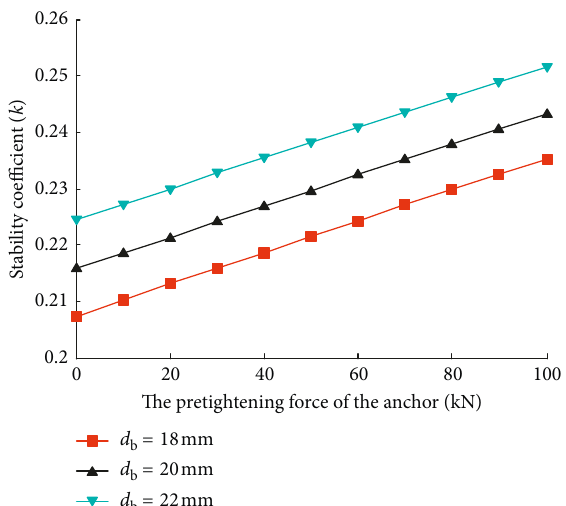
Figure 9: Influence of the anchor pretightening force and anchor diameter on the stability of the surrounding rock.